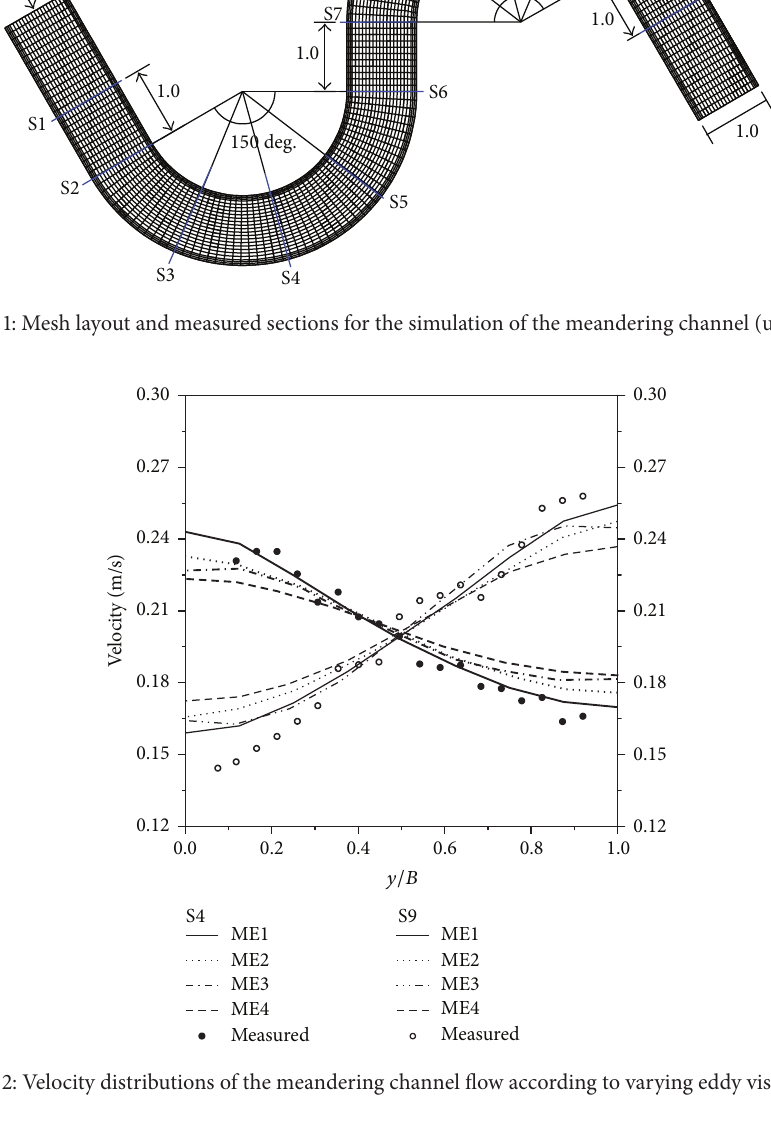
1.52. Seo and Park [54] measured three-dimensional